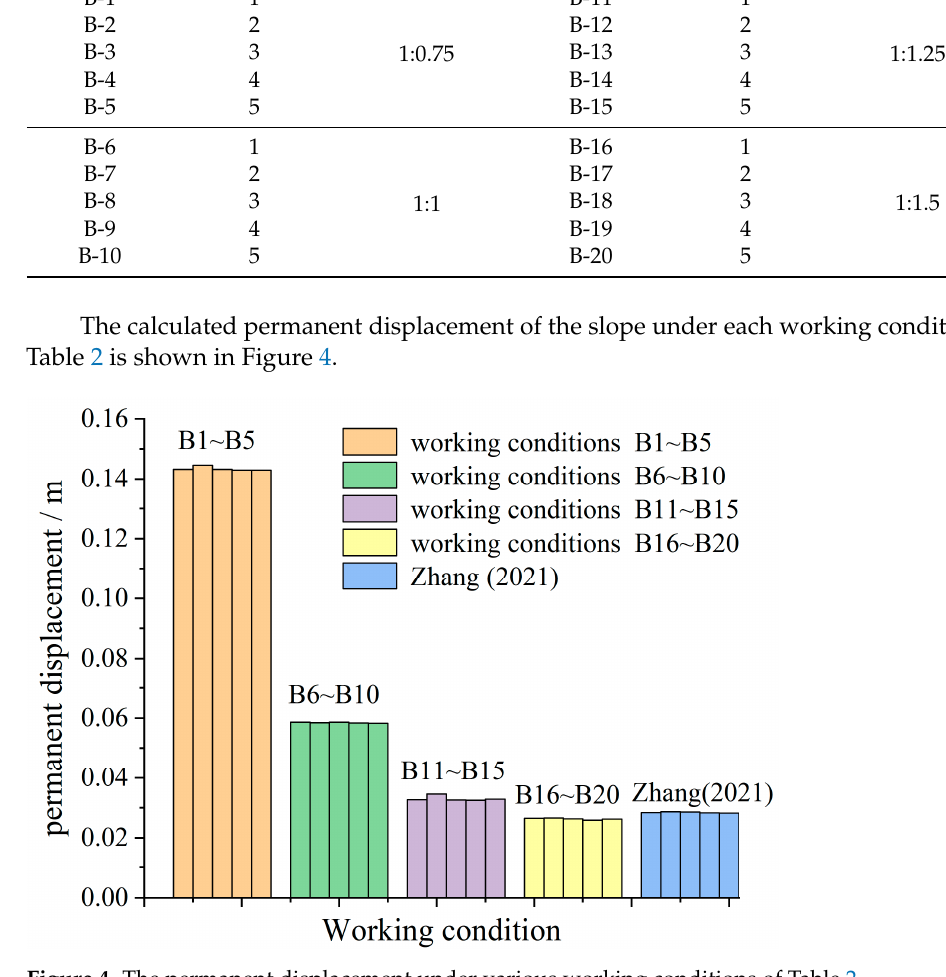
Figure 4. The permanent displacement under various working conditions of Table